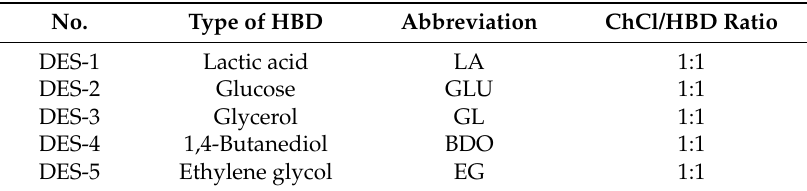
Table 1. Different composition of DESs applied in this